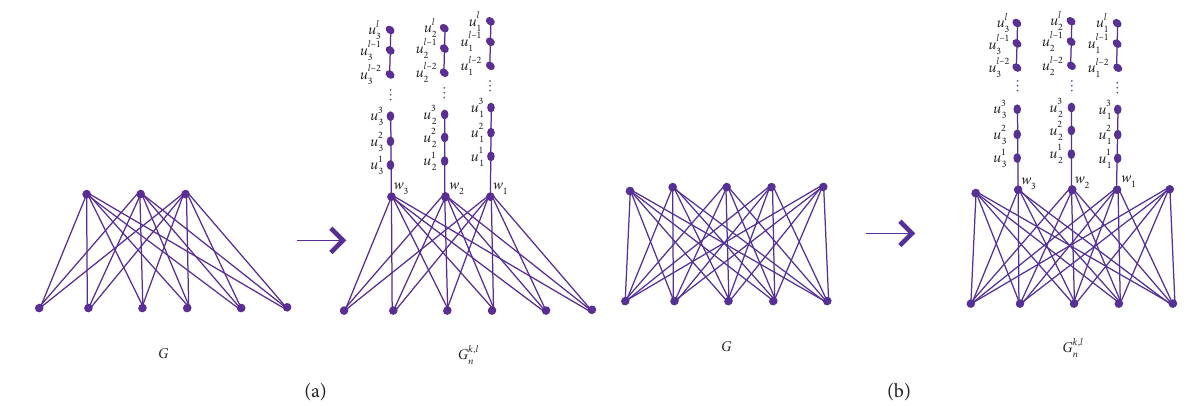
Figure 1: Graph Γ k,l